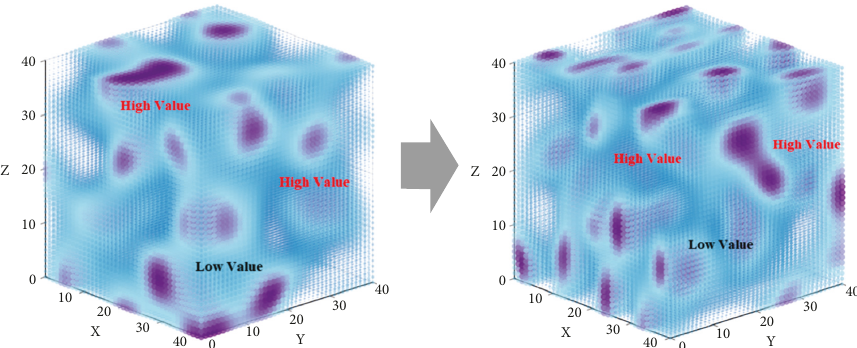
Figure 9: The results of small- and medium-sized enterprise economic management system.